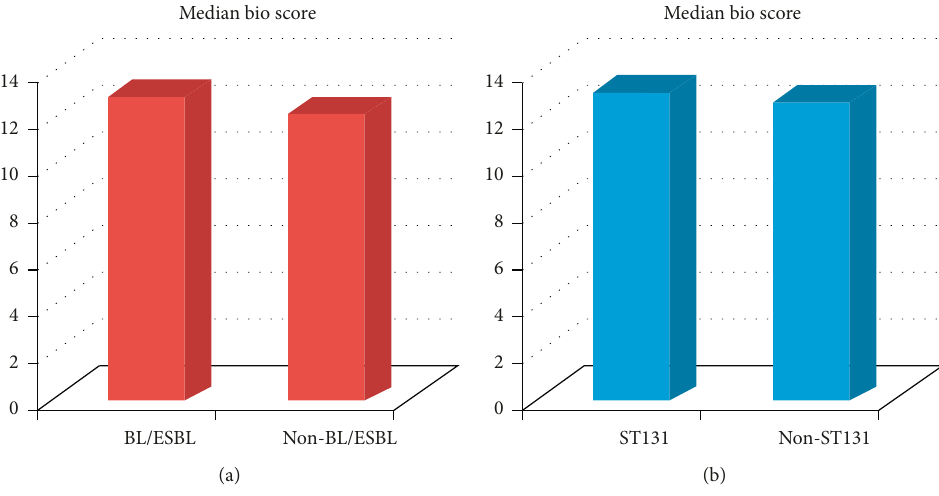
Figure 2: (a) Median bio-scores of BL/ESBL and non-BL/ESBL isolates. The difference between the two isolate groups was insignificant ( p � 0.77). (b) Median bio-scores of ST131 and non-ST131 isolates. The difference between these isolate groups was insignificant ( p �